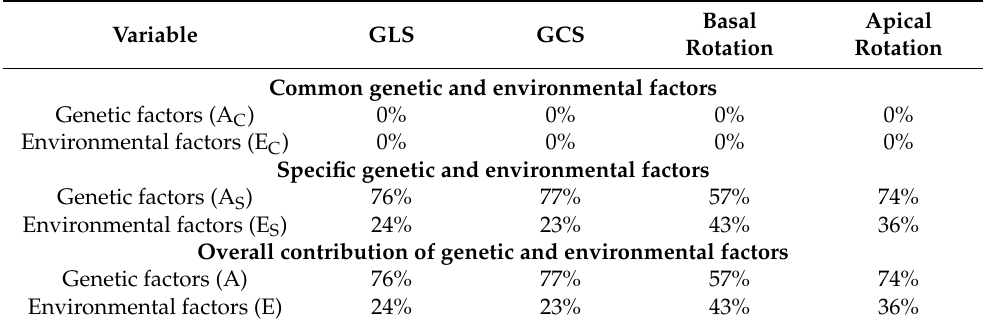
GLS: global longitudinal strain; GCS: global circumferential strain; Ac: common genetic factors; Cc: common environmental factors; Ec: common unique environmental factors; As: specific genetic factors; Cs: specific common environmental factors; Es: specific unique environmental